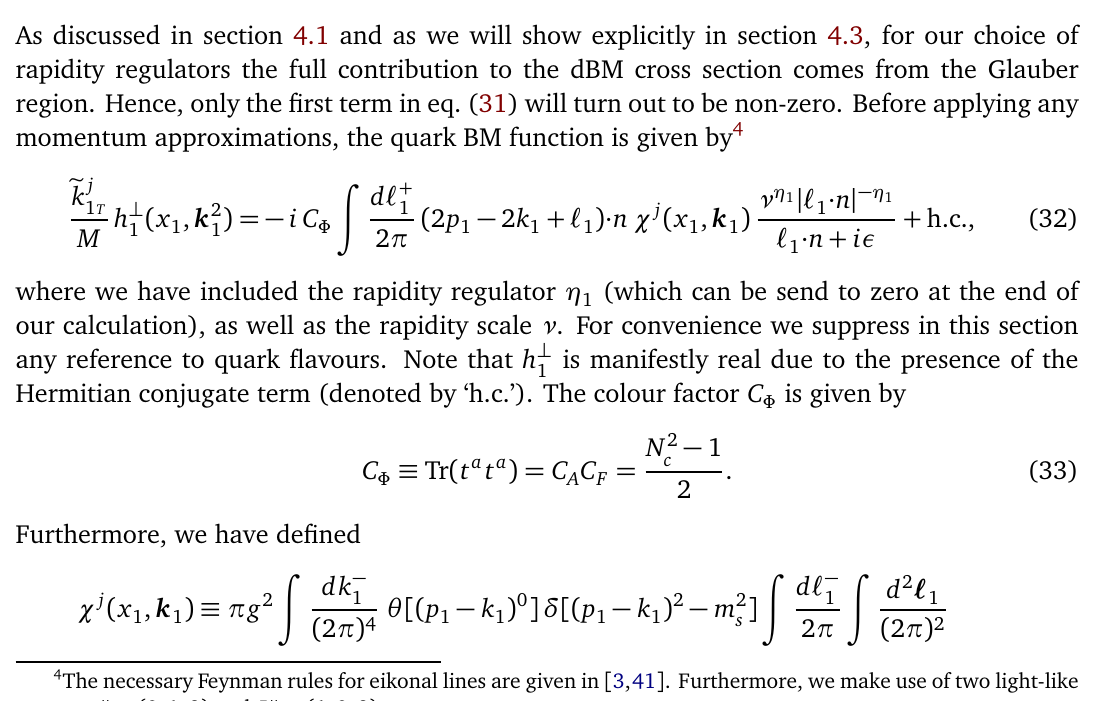
Figure 8: The first-order contribution to the quark BM function h ⊥ Hermitian conjugate graph is